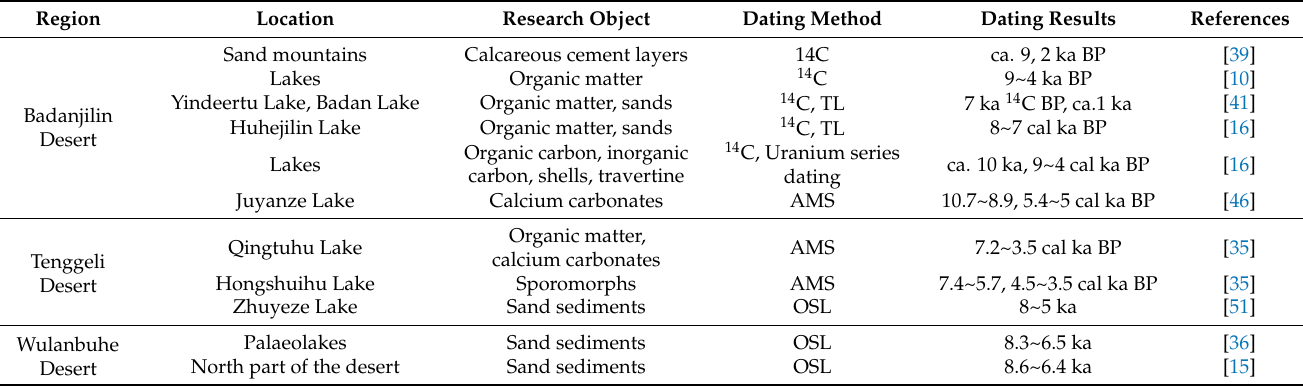
Table 2. A study of the environmental indicators since the Holocene on the Alashan